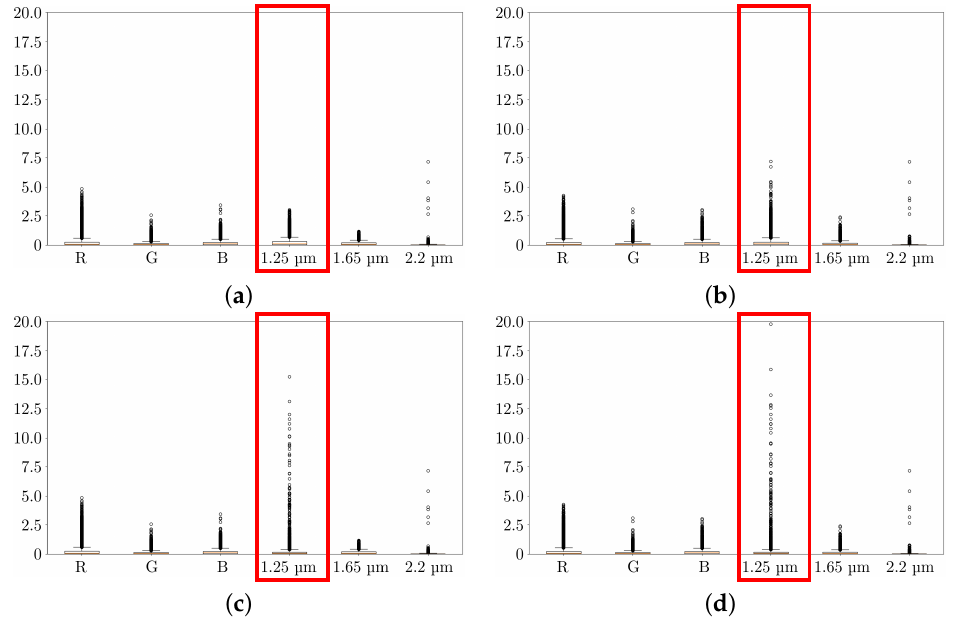
Figure 10. “Gardanne” urban dataset: box plots and outliers depicting the distribution of the NG criterion (not converted into percentage), for the six analysed spectral bands. ( a ) Gain-2P—0.95 µ m, ( b ) CONDOR-2P—0.95 µ m, ( c ) Gain-2P—1.35 µ m, and ( d ) CONDOR-2P—1.35 µ